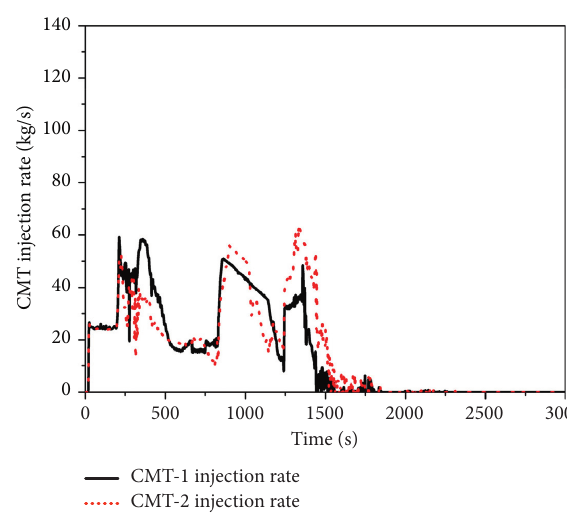
Figure 14: 2-inch CL break CMT injection mass flow rate.